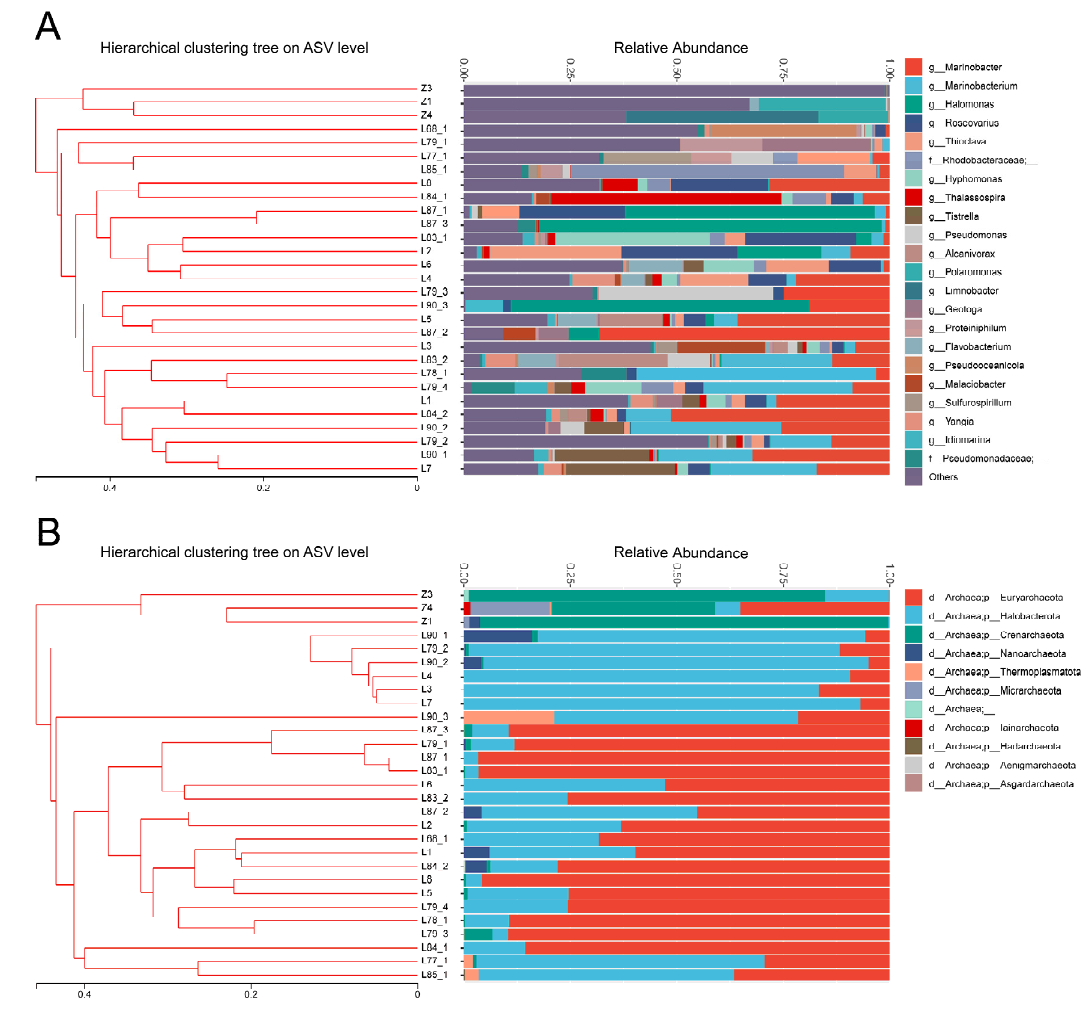
Figure 1. Microbial composition of the injected and produced water samples. ( A ) bacterial composition at the genus level. The taxa with average relative abundances of less than 1% were grouped as “Others”. ( B ) archaeal composition at the phylum level.